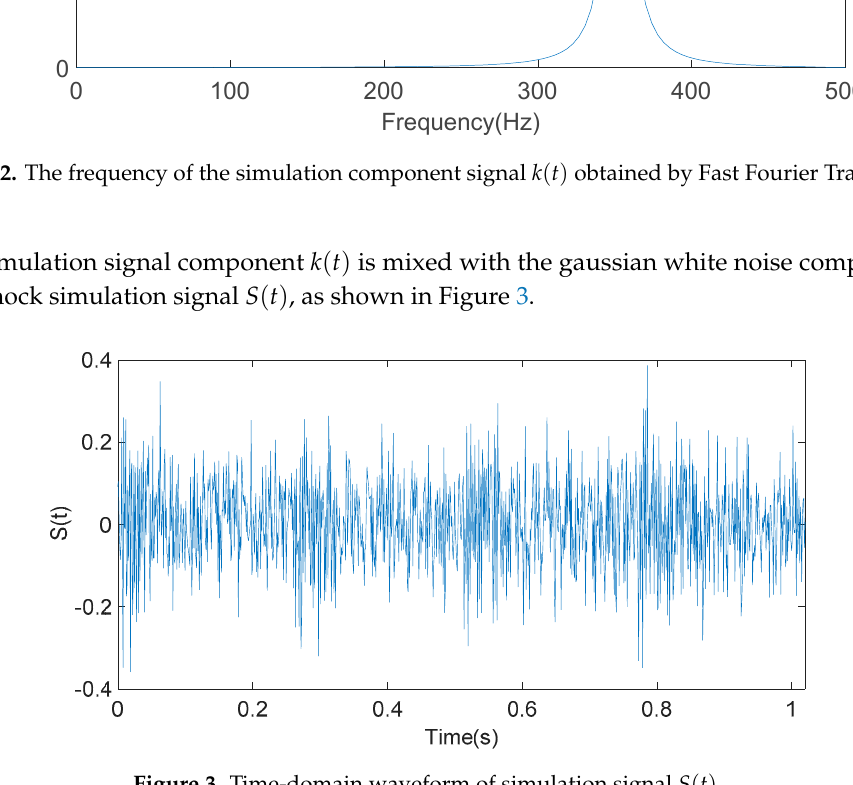
Figure 3. Time-domain waveform of simulation signal S ( t )